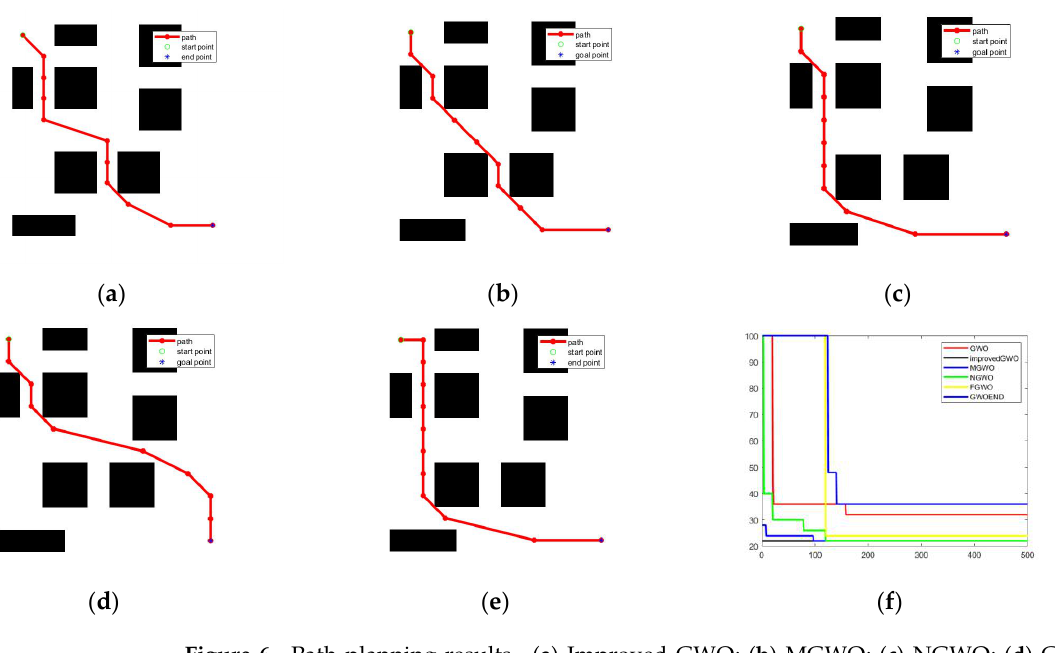
Figure 6. Path planning results. ( a ) Improved GWO; ( b ) MGWO; ( c ) NGWO; ( d ) GWO-fuzzy; ( e ) GWO-EPD; ( f ) convergence curves.